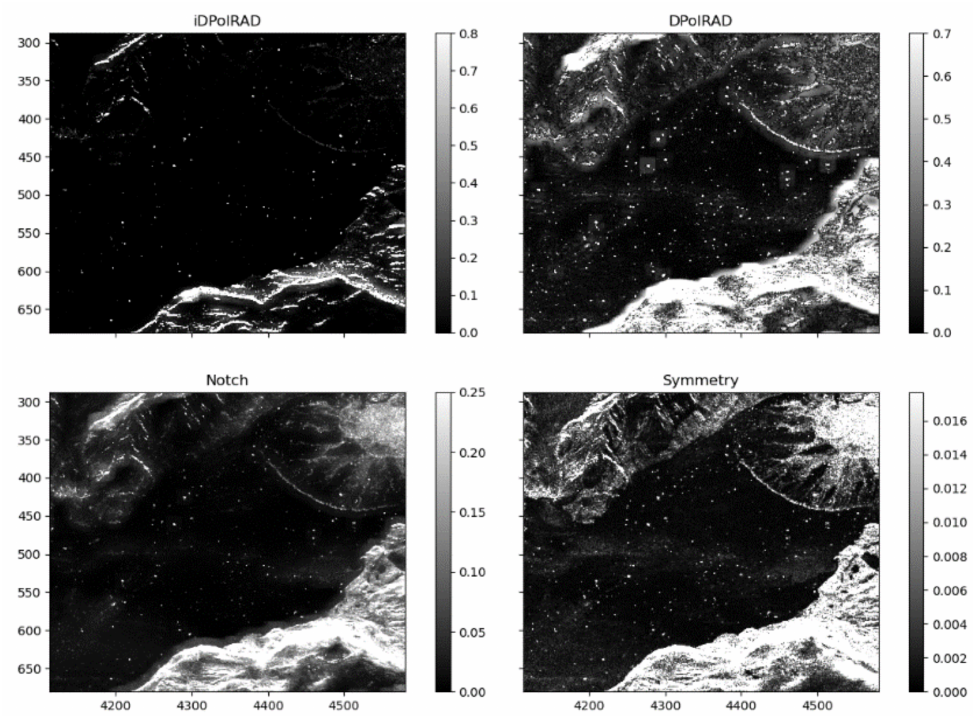
Figure 8. Iceberg detection iDPolRAD, DPolRAD, notch filter and symmetry for Blosseville. Image size is 350 × 500 pixels. Greyscales indicate detection intensity.